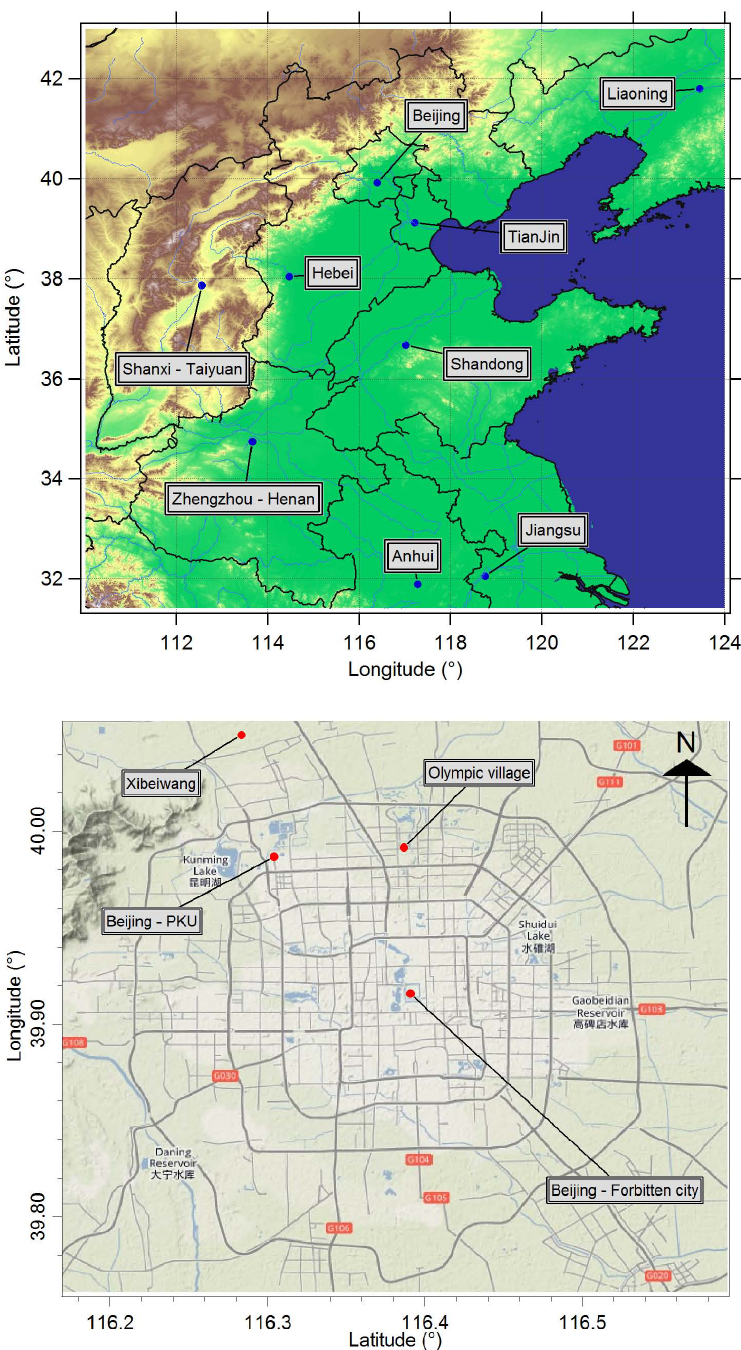
Fig. 4. Beijing city and measurement site (bottom) and surrounding regions